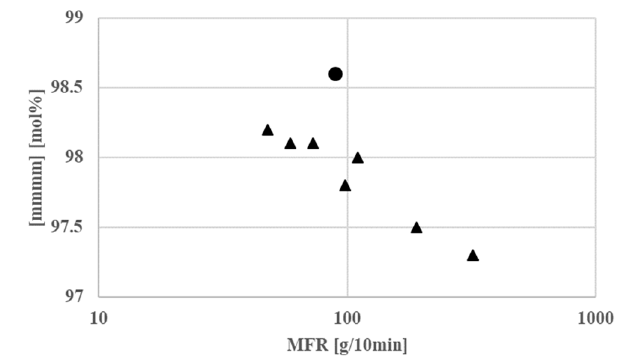
Figure 3. Relationship between MFR vs [mmmm]; ● : U-donor, ▲ : alkyl triethoxy silane compounds.